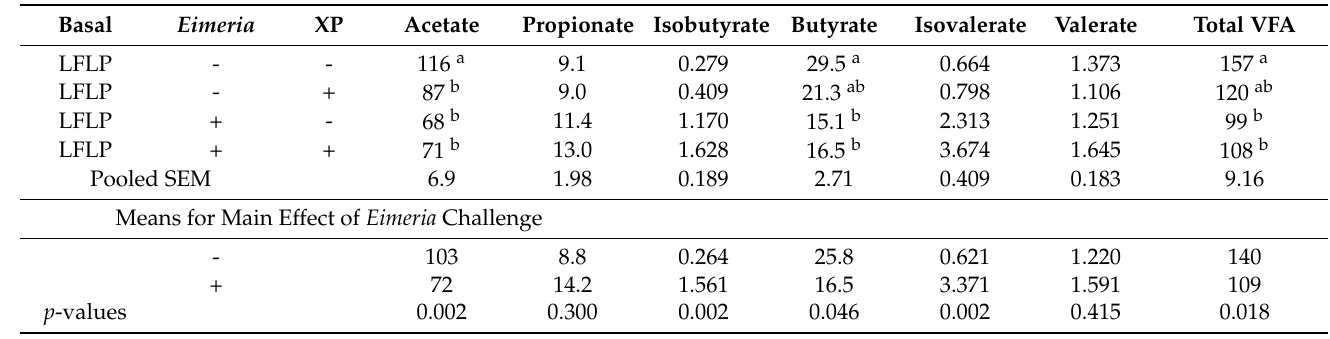
Table 11. Short-chain fatty acid profile (mM) in cecal content for the broiler chickens challenged or unchallenged with mixed Eimeria spp. in response to feeding diets with low fiber and protein levels with or without enzyme supplementation (Expt.